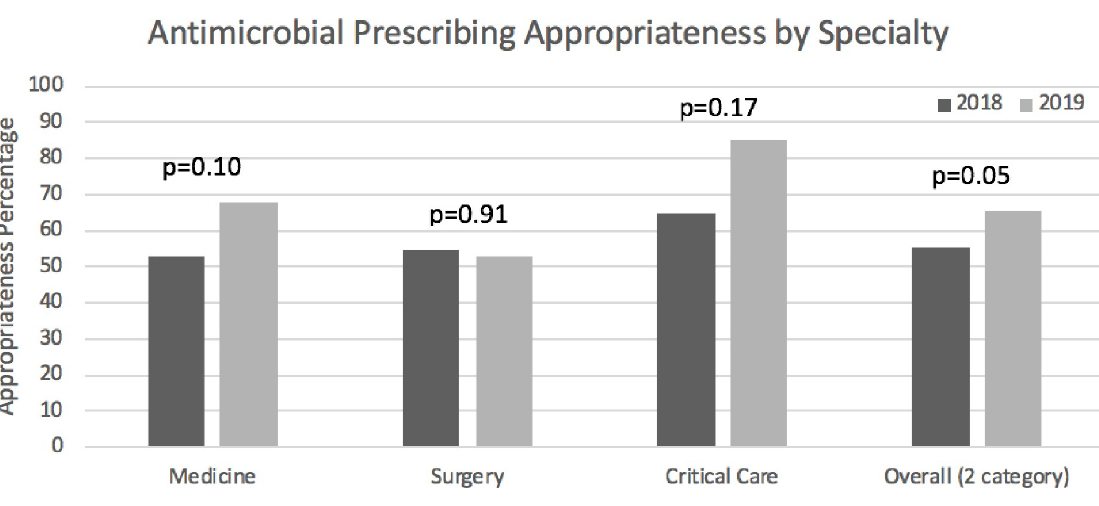
Refer to Table 1 for results of appropriateness by category. Improvements were observed in appropriateness of dose/frequency, duration, route, microbiology mismatch, missing indica- tion, and target tissue mismatch.